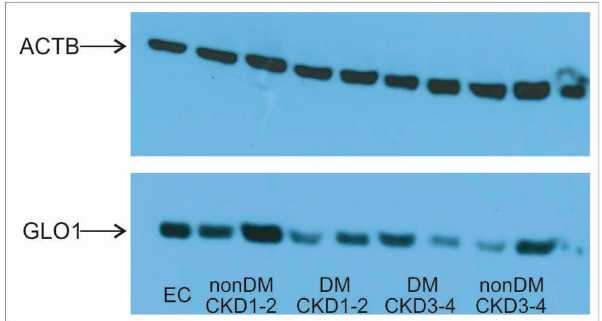
Figure 2. Representative Western blot of GLO1 protein. Figure shows from left endogenous control (EC) and two random patients from each group of subjects. DM—diabetes mellitus; CKD—chronic kidney disease; GLO1—glyoxalase; ACTB— β